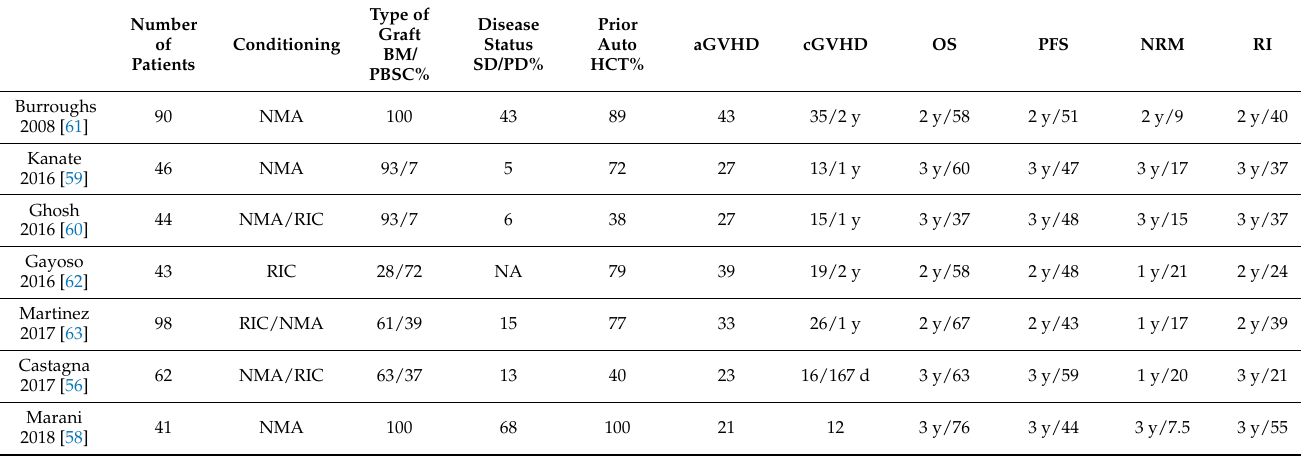
Table 5. Haplo-SCT in Hodgkin disease using